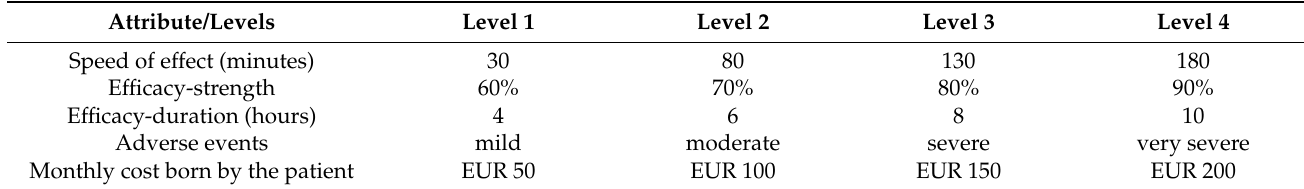
Table 1. Description of attributes and